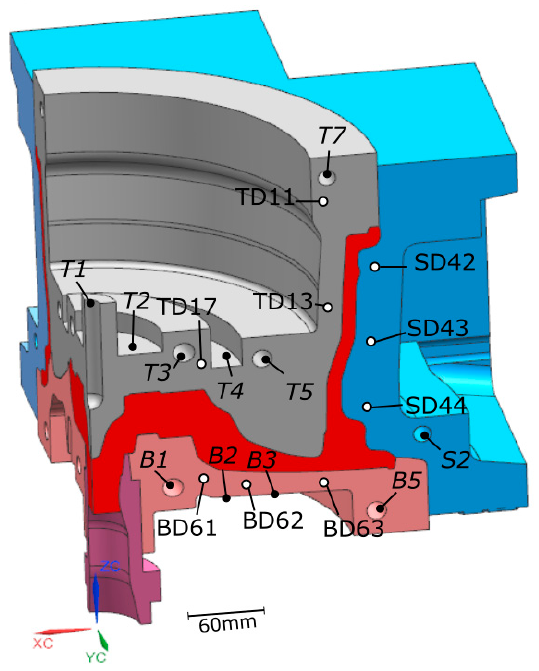
( a ) Locations of the cooling channels (labeled B x , S x , and T x ) and the nine selected TCs for model validation (labeled as BD x , SD x , and TD x ) in Die-A.